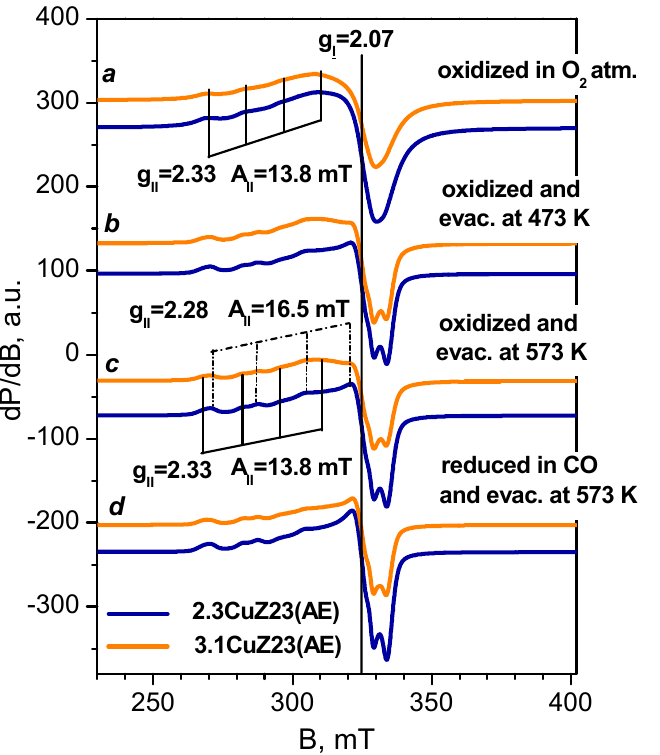
Figure 5. In situ EPR spectra at 295 K of 3.1CuZ23(AE) and 2.3CuZ23(AE): annealed in O 2 at 400 ◦ C ( a ), evacuated at 200 ◦ C ( b ), evacuated at 300 ◦ C ( c ) and reduced with CO at 300 ◦ C ( d ). The simulated EPR parameters are designated for selected samples.